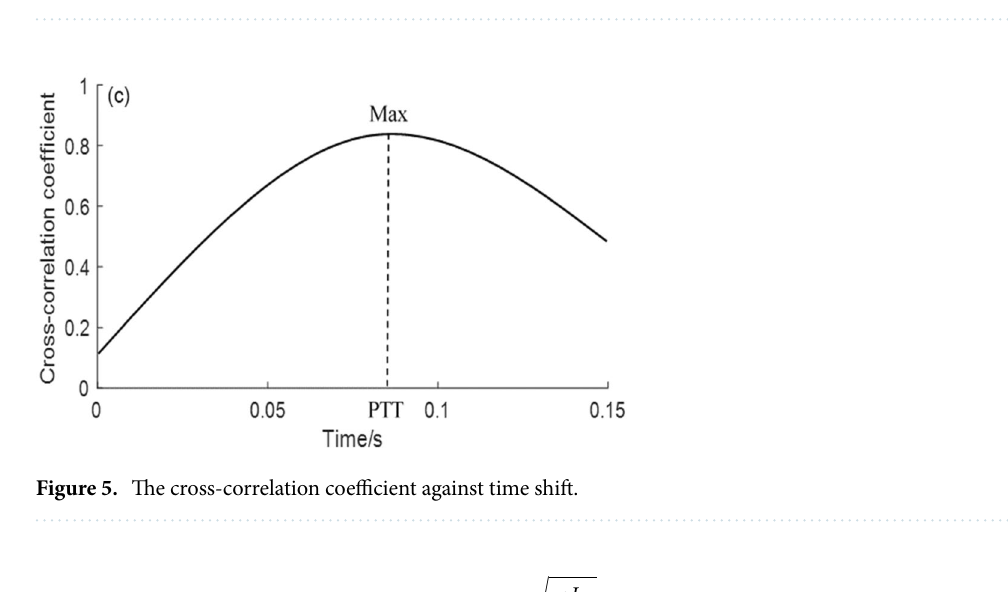
Figure 4. Graphical representation of the cross-correlation method showing its effect on a single heart beat: ( a ) the original carotid and femoral waveforms; ( b ) the femoral waveform having been shifted back in time by an amount determined by the maximum cross-correlation coefficient.